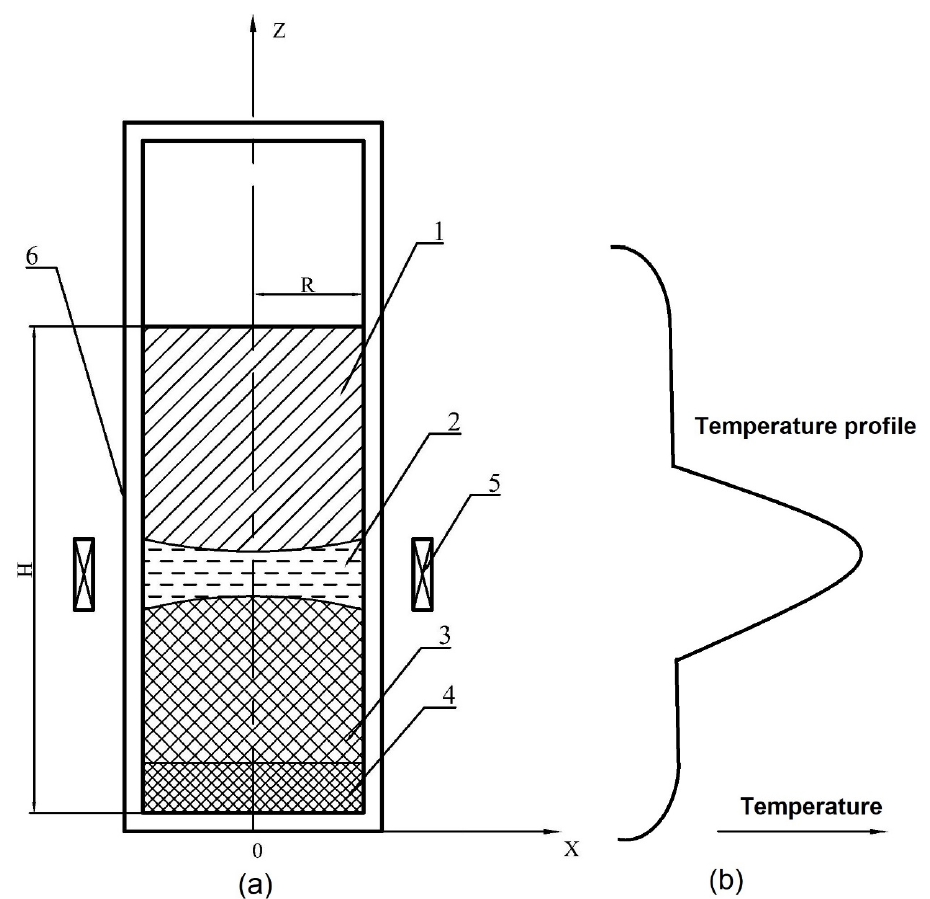
Figure 1. Diagram of the crystal growth system ( a ) and the furnace chamber temperature curve ( b ): 1, polycrystalline ingot; 2, melting zone; 3, crystal; 4, initial seed crystal section; 5, heater; 6, crucible.